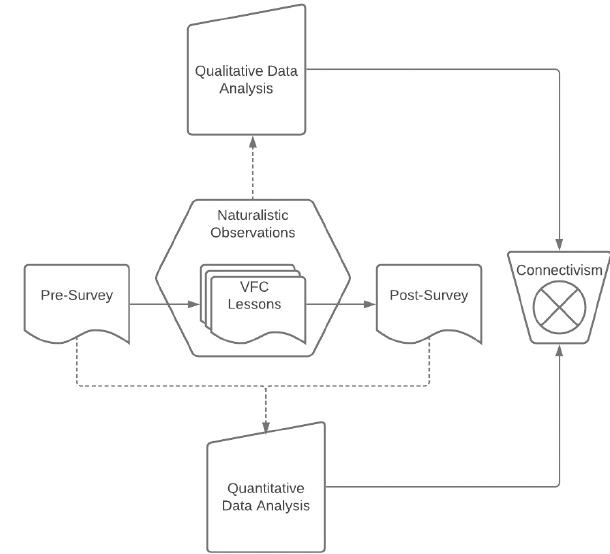
Figure 2. The mixed method study design for the